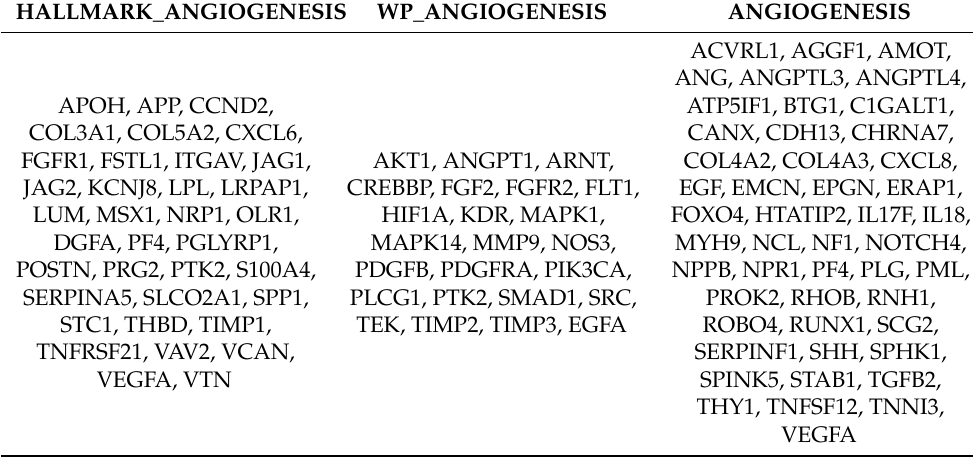
Table 1. Angiogenesis-related